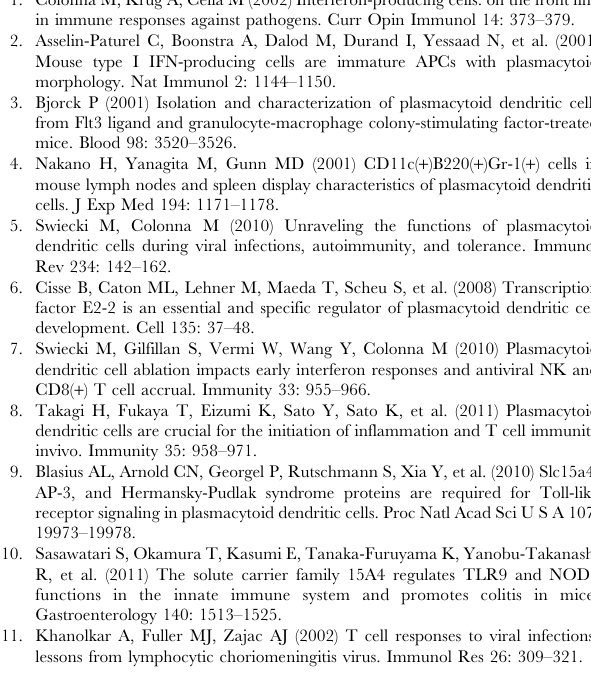
Figure S3 feeble CD8 T cells and antigen presenting